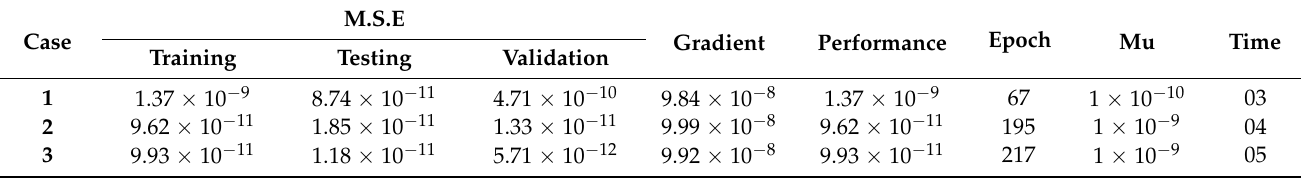
Figure 5. Results comparison and EHs to solve the nonlinear COVID-19 spreading model. Table 1. ANNs-LMB to solve nonlinear the COVID-19 spreading